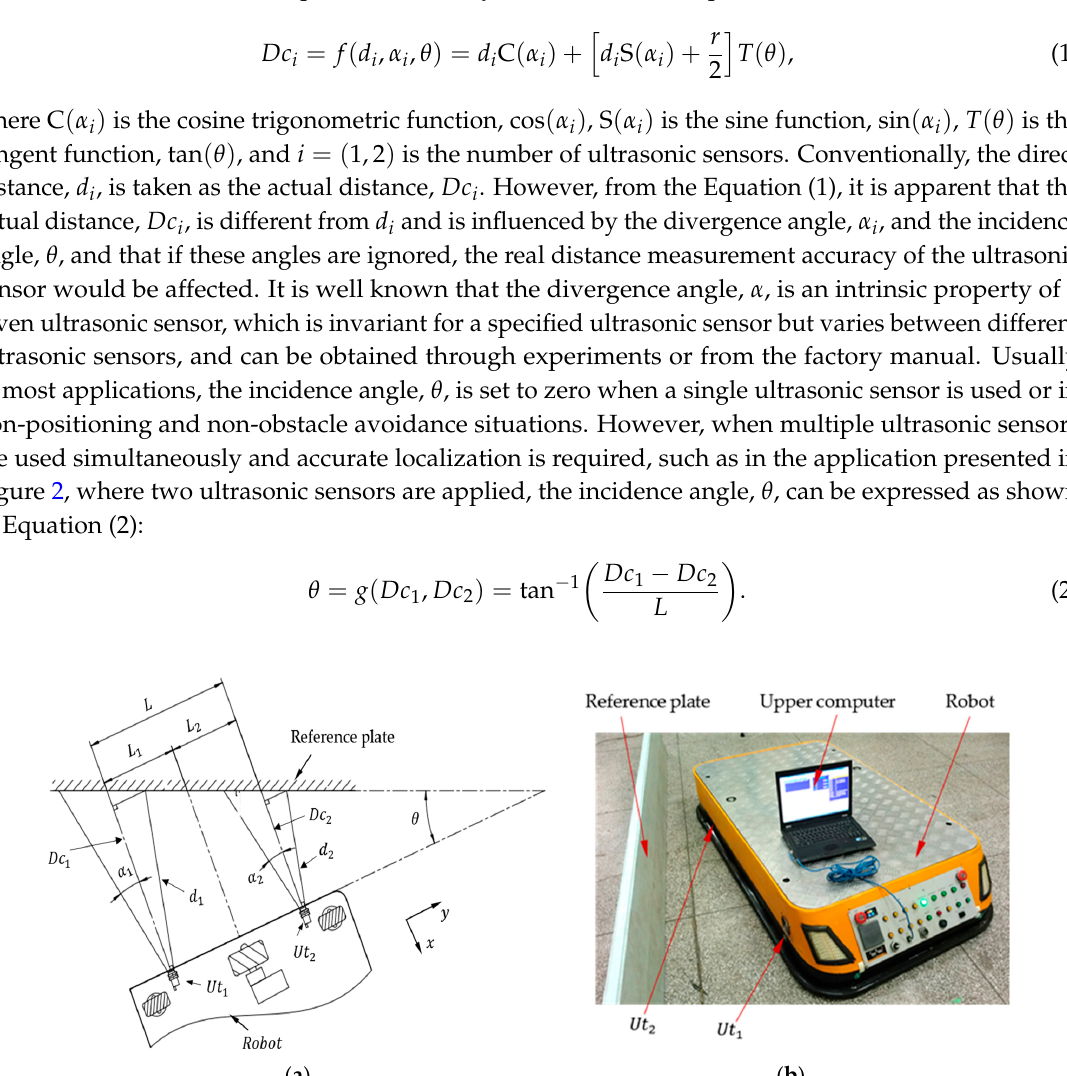
Figure 1. The divergence angle and the incidence angle.